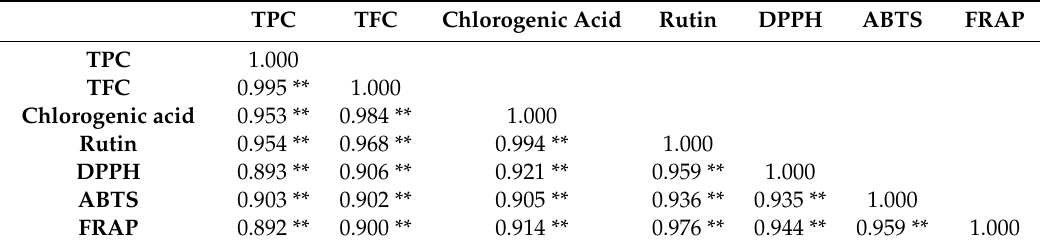
Table 4. Pearson’s correlation coe ffi cient among TPC, TFC, chlorogenic acid, rutin and in vitro antioxidant activities of the leaves of C.